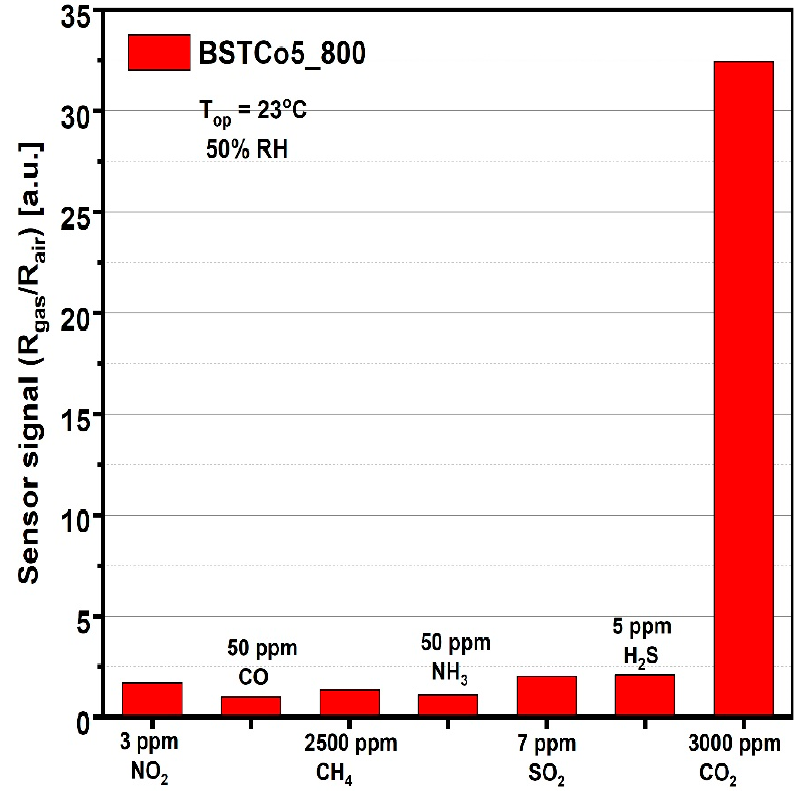
Figure 11. Sensor signal for 3000 ppm CO 2 and for other potential interfering gases.